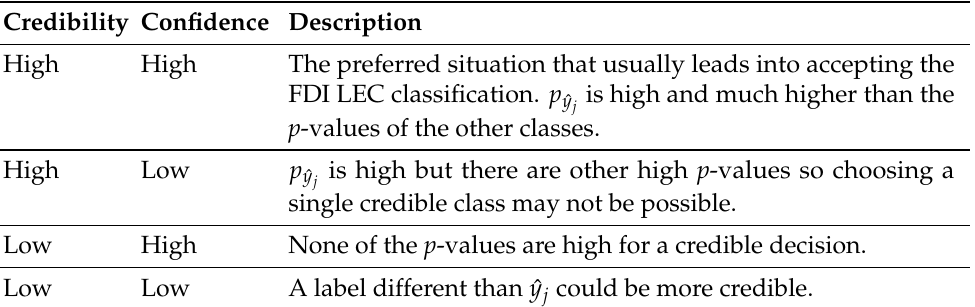
Table 2. Scenarios that can be observed for different values of confidence and